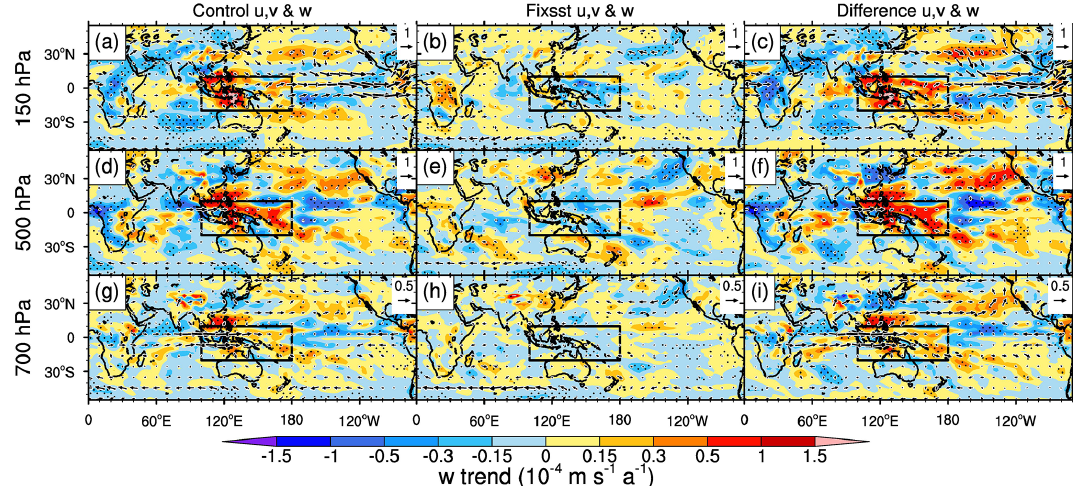
Figure 5. Same as Fig. 2 but for the Control simulation ( a , d , and g ), Fixsst simulation ( b , e , and h ), and the difference between the simulations ( c , f , and i ). The vertical velocity trends over the dotted regions are statistically significant at the 95% confidence level. The black rectangles denote the TWP region (20 ◦ S–10 ◦ N, 100–180 ◦ E).